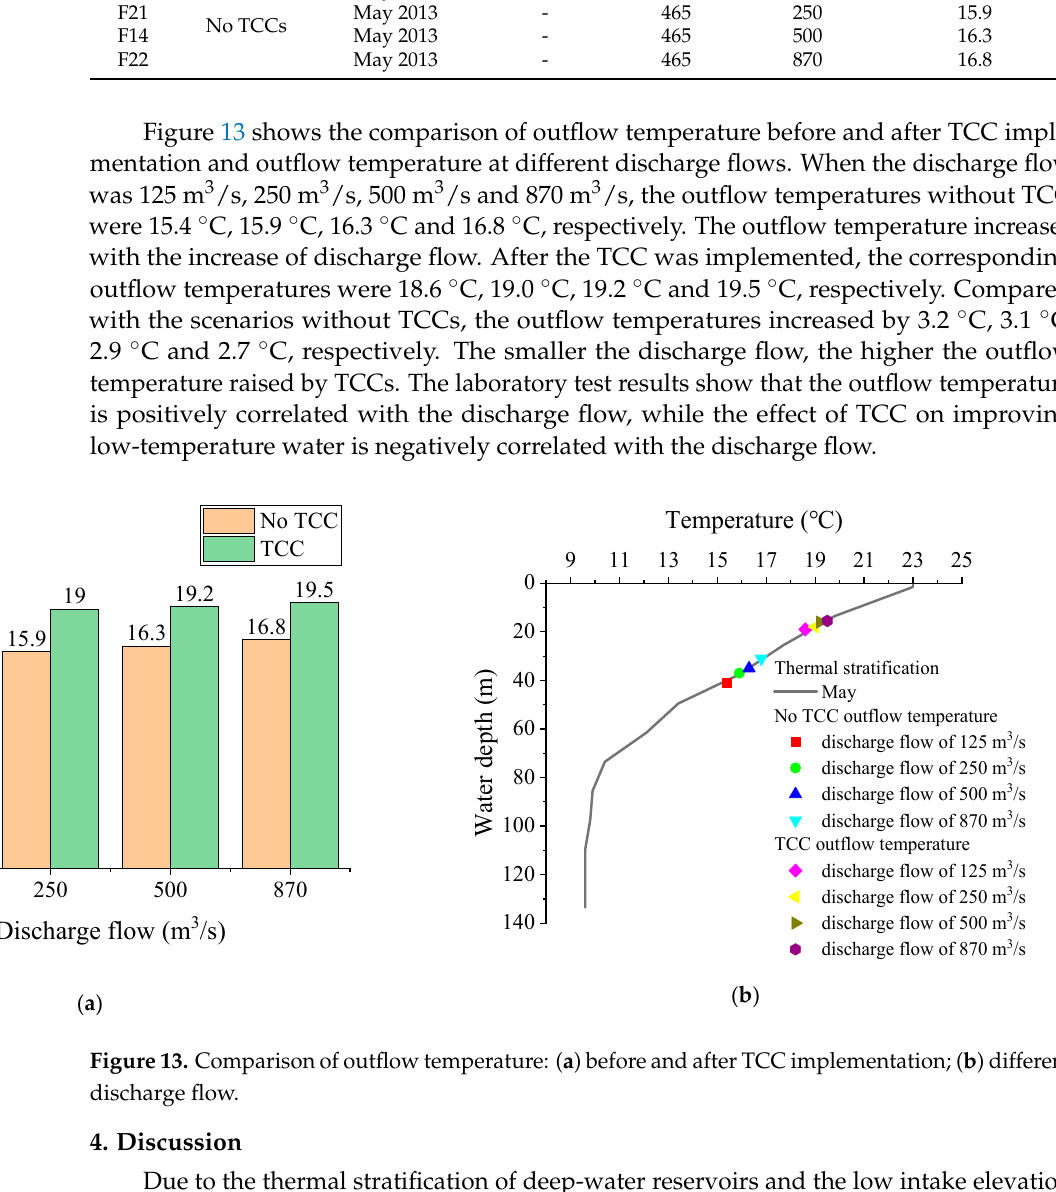
Table 8. Different discharge flow test scenarios and results.